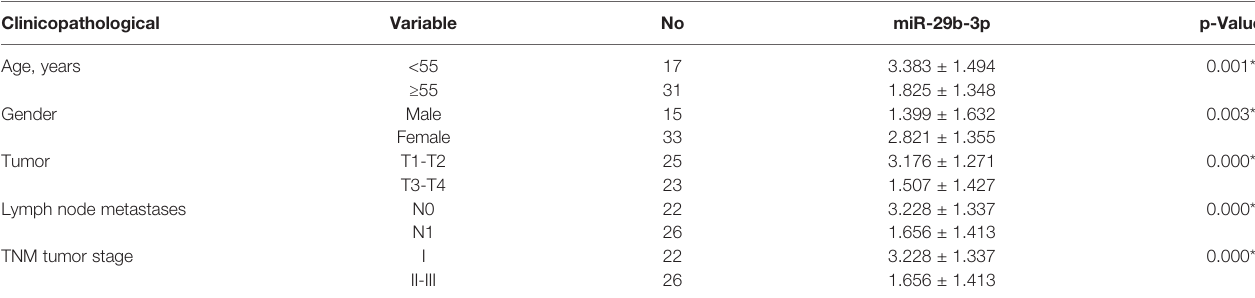
TABLE 2 | The relationship between the relative expression of miR-29b-3p and clinicopathological characteristics in thyroid cancer patients. Clinicopathological